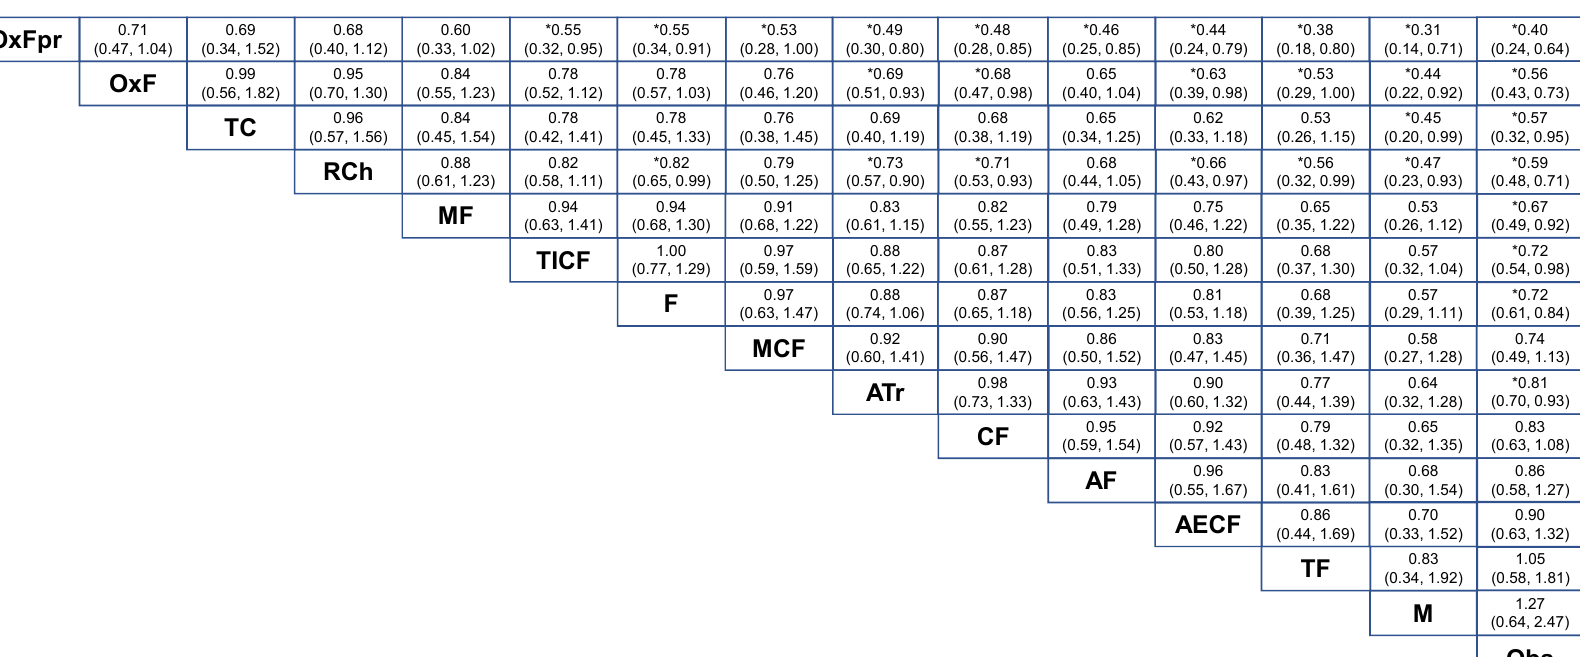
Figure 6. Results of the adjuvant therapy for curatively resected gastric cancer random effects network meta-analysis (NMA-2) for 14 different treatment modalities in terms of disease free survival. Relative effects in combined hazard ratios and 95% credible intervals are shown for the combination chemotherapy regimens. The hazard ratio for a given comparison could be read in the intersection of two treatments. The strategies are grouped according to their baseline efficacy compared with observation-alone. All z-tests to compare two treatments were performed two-sided. * p < 0.05. Abbreviations: A = anthracycline; ATr = anthracycline-based triplet; C = cisplatin; E = etoposide; F = fluoropyrimidine; I = irinotecan; M = mitomycin C; Obs = observation; Ox = oxaliplatin; OxFpr = eight cycles of oxaliplatin-fluoropyrimidine thereafter eight cycles of fluoropyrimidine monotherapy; RCh = chemoradiotherapy; T =